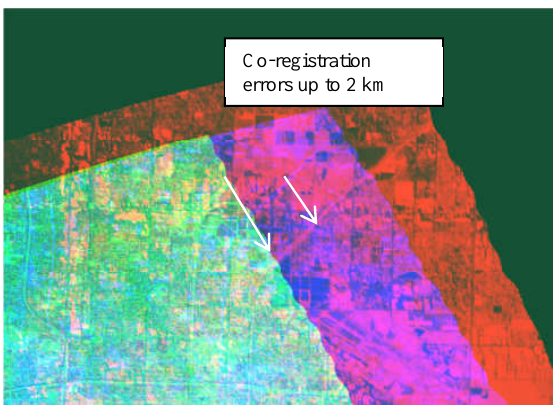
Figure 3. Before adjustment: AirMSPI 660 nm Intensity layers (upper right corner): 1) Red: +60º, 2) Green: 0º, and 3) Blue: -47.5º.